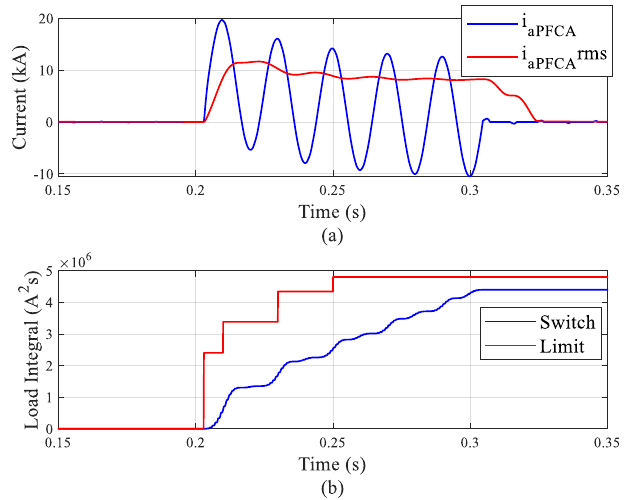
Figure 12. PFCA current requirements, phase a. ( a ) PFCA current; ( b ) limiting load integral on a